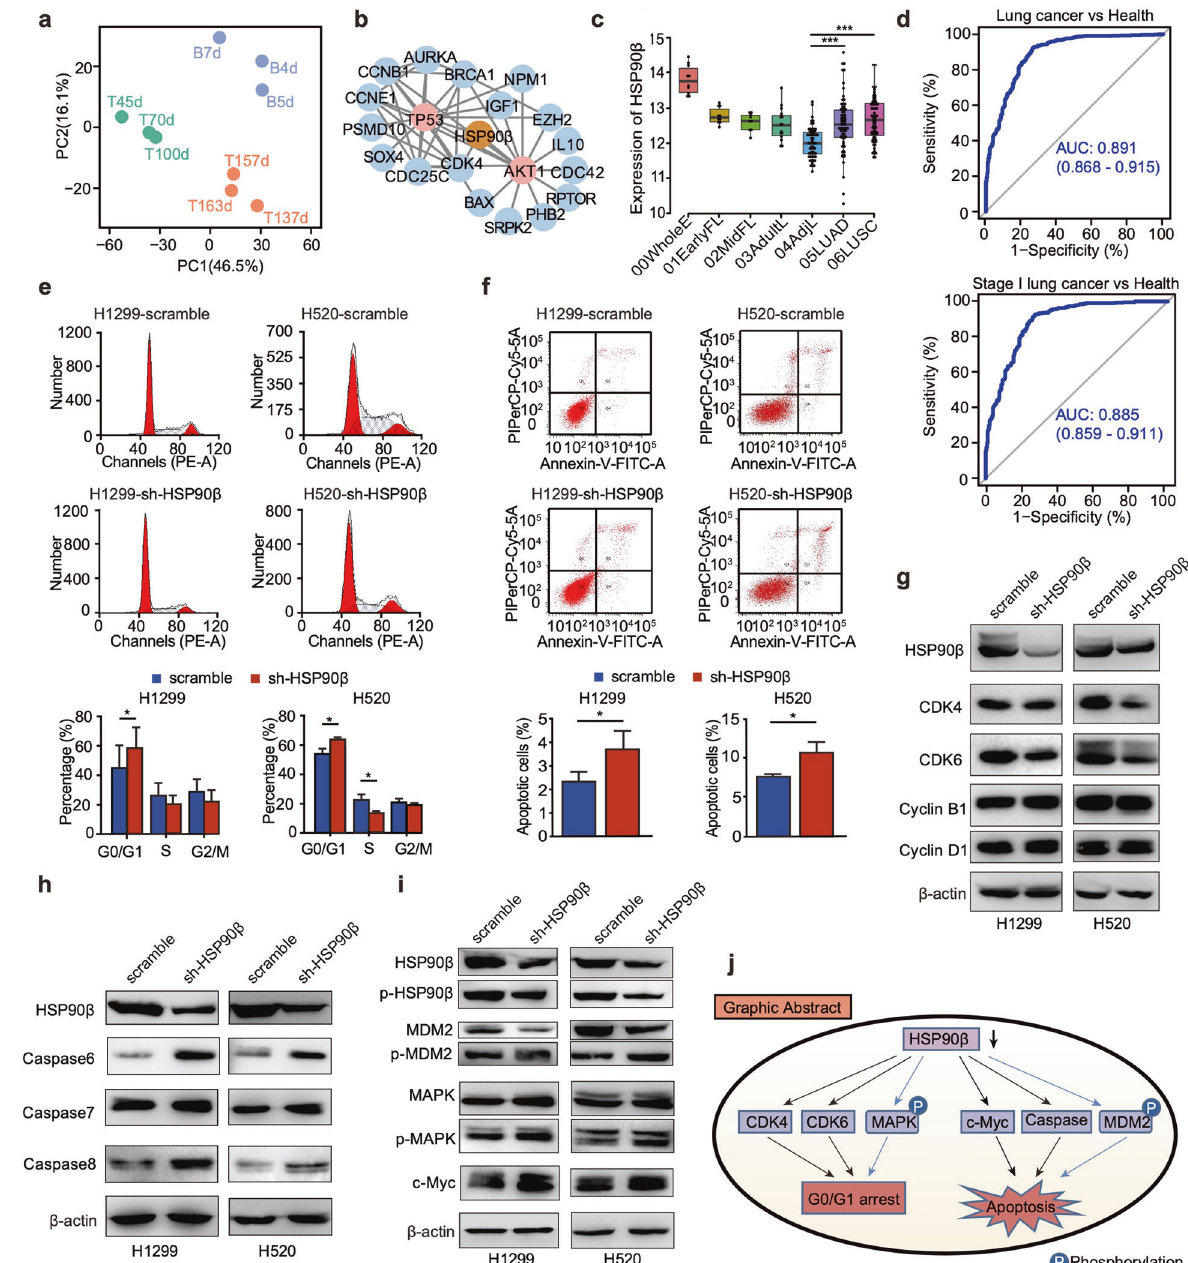
Fig. 1 a PCA (principal component analysis) of temporal RNA-seq data to separate the whole rhesus macaque lung developmental process into three phases (Ph1: early stage, including T45d, T70d, T100d; Ph2: middle stage, including T137d, T157d, T163d; Ph3: late stage, including B4d, B5d, B7d). b Protein – protein interaction (PPI) network involved in cell cycle regulation identi fi ed at the Ph1. c The gene expression of HSP90 β in four developmental stages of human lung tissues and lung cancer tissues ( “ 00WholeE ” : whole embryos at PWs 3 – 5, n = 10; “ 01EarlyFL ” : lungs at 6 – 8 PWs, n = 10; “ 02MidFL ” : lungs at 16 – 24 PWs, n = 9; “ 03AdultL ” : adult lung tissues, n = 15; “ 04AdjL ” : adjacent normal lung tissues, n = 60; “ 05LUAD ” : LUAD tissues, n = 69; “ 06LUSC ” : LUSC (lung squamous cell carcinoma) tissues, n = 69). Mann – Whitney U test was used to verify the signi fi cance between “ 04AdjL ” and “ 05LUAD ” , “ 04AdjL, ” and “ 06LUSC. ” d ROC (receiver-operating characteristic) curve of HSP90 β in distinguishing NSCLC patients from healthy controls (upper panel) and ROC curve of HSP90 β in distinguishing stage I NSCLC patients from healthy controls (lower panel, AUC: Area under the ROC curve. The 95% CI is indicated in parentheses). e Cell cycle of H1299 and H520 cells (top panel shows images of the cell cycle in the scramble and HSP90 β knockdown cells, bottom panel shows the statistical column diagram (Student ’ s t test). f Cell apoptosis of H1299 and H520 cells (top panel shows images of the cell apoptosis, the bottom panel shows the statistical column diagram) (Student ’ s t test). g Western blot of cell cycle-related proteins in H1299 and H520 cells. h Western blot of cell apoptosis-related proteins in H1299 and H520 cells. i Western blot of several phosphorylated proteins involved in the cell cycle and apoptosis. j Graphical abstract of the effects of HSP90 β on the cell cycle and apoptosis. *** P < 0.001; * P < 0.05